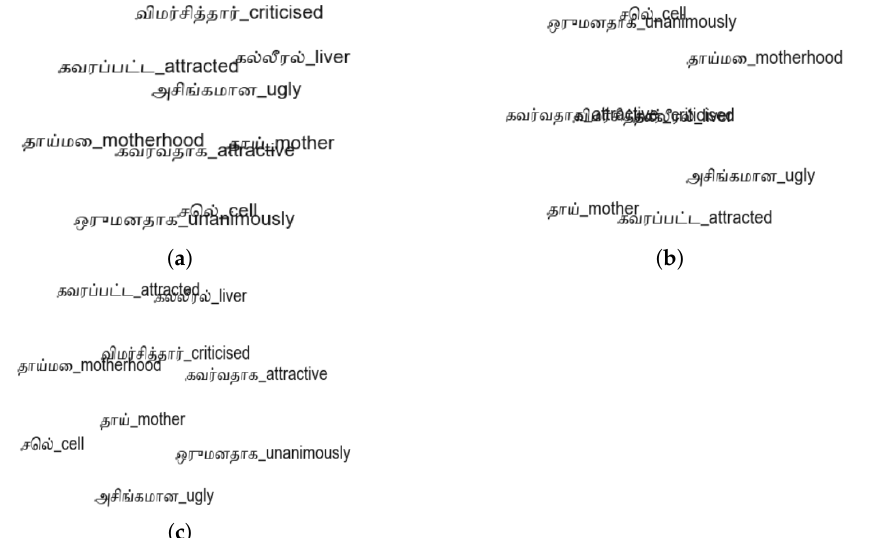
Figure 11. t-SNE visualization of transfer-learned Tamil vectors (MLP and CNN) and original vectors generated by GloVe. ( a ) Original Embeddings; ( b ) Embeddings generated by MLP; ( c ) Embeddings generated by